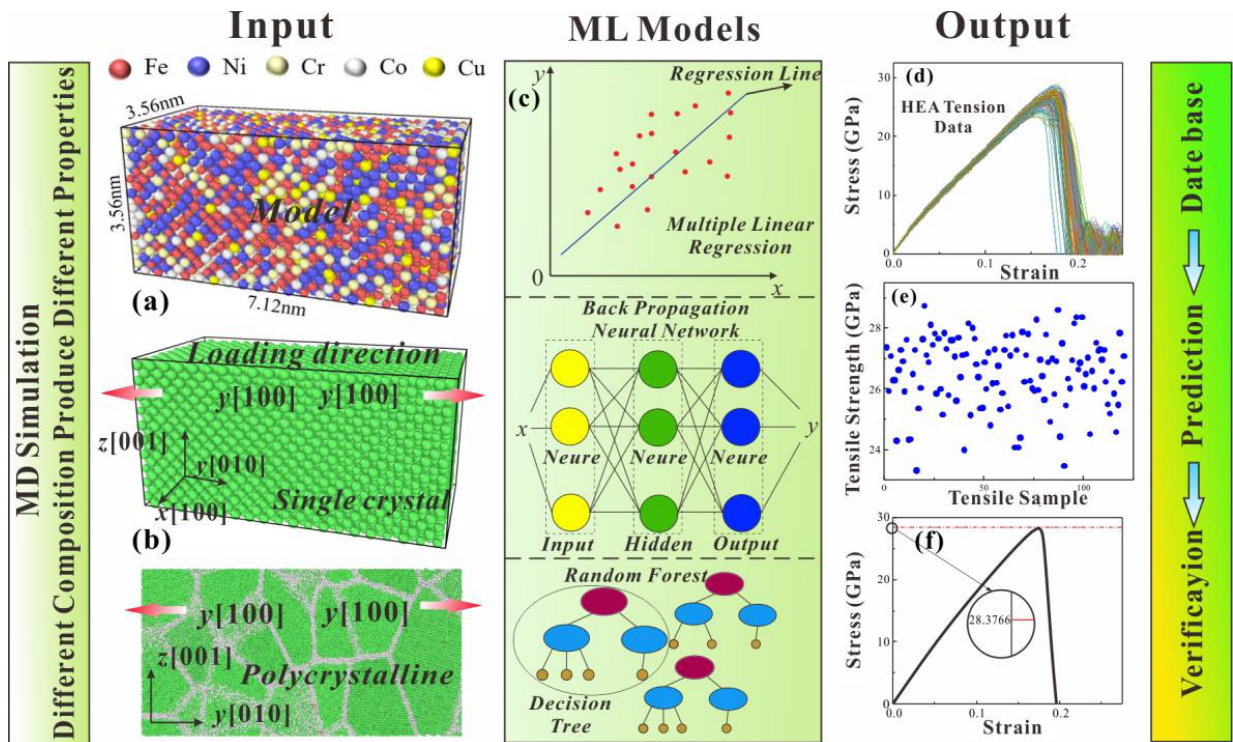
Figure 1. ( a ) Tensile model diagram of FeNiCrCoCu HEA, ( b ) Single crystal model diagram of HEA, ( c ) Three ML models: multiple linear regression (MLR), back propagation neural network (BPNN) and random forest (RF), ( d ) Stress-strain curves for 120 tensile models, ( e ) Tensile strength distribution of 120 tensile models, ( f ) Stress-strain curves of HEAs simulated by MD to verify optimal mechanical properties. Table 1. Parameters in EAM potential functions [37].